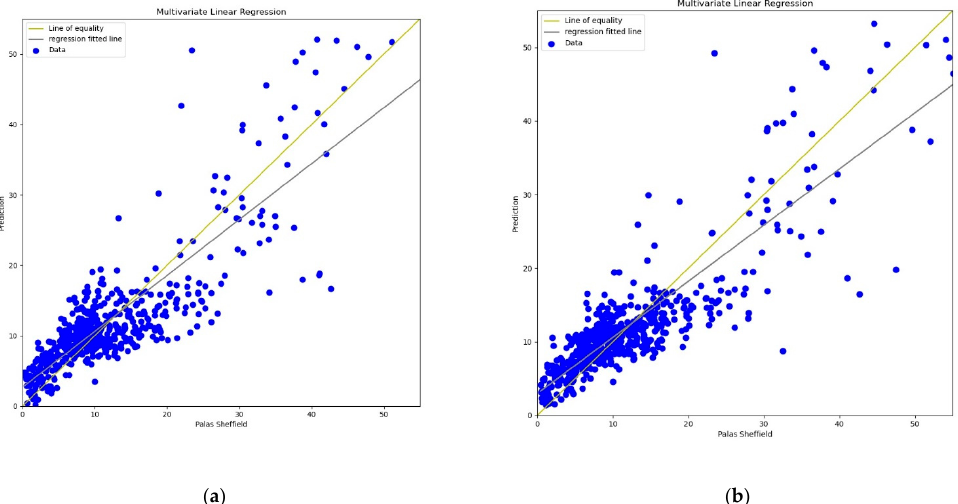
Figure 7. ( a ) MLR calibration scatter plot for PM 10 with the line of equality, regression fitted line, and the calibrated data using AH ; ( b ) MLR calibration scatter plot for PM 10 with the line of equality, regression fitted line, and the calibrated data using RH .